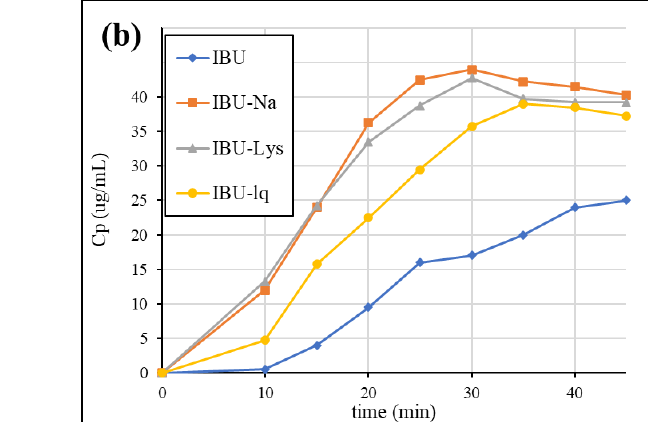
Figure 5. Gastric concentration profiles of ibuprofen formulations (1 × 200 mg) in blank biorelevant media.